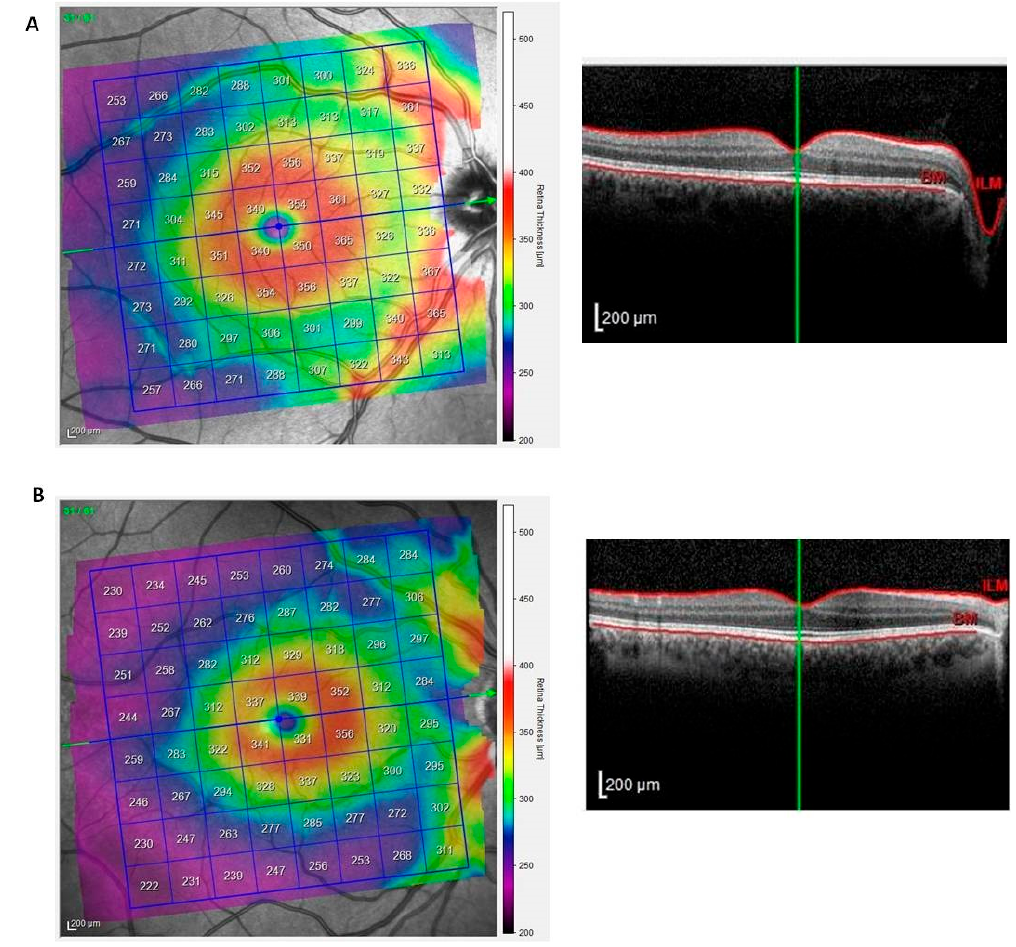
Figure 5. Total retinal thickness of the posterior pole in patients with psoriatic arthritis sine psoriasis. The posterior pole scanning protocol was performed with SD-OCT. Representative scans of the total retinal thickness of the posterior pole from a healthy control and a patient with psoriatic arthritis are depicted in panels ( A , B ). The left image shows the color-coded map of the posterior pole. The right image is the respective cross-sectional OCT scan as a grayscale image. The green line indicates the location of the cross-section.